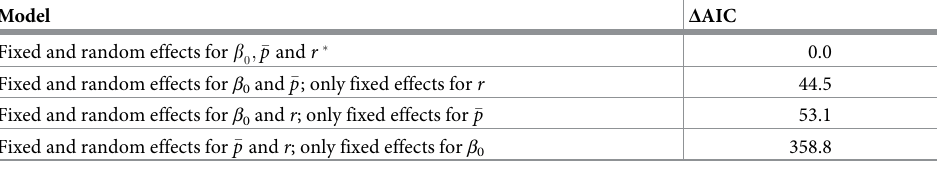
Table 3. Model comparisons of adherence and CD4 recovery parameters. AIC values ( Δ AIC) are quoted relative to the minimum AIC value across all models. The model with Δ AIC = 0 is the model with lowest AIC and thus has most statistical support. See Table 1 for parameter definitions. Model Fixed and random effects for b ; � p and r � 0 Fixed and random effects for β 0 and � p ; only fixed effects for r 44.5 Fixed and random effects for β 0 and r ; only fixed effects for � p 53.1 Fixed and random effects for � p and r ; only fixed effects for β 0 358.8 � Corresponds to the best-fit model in Table